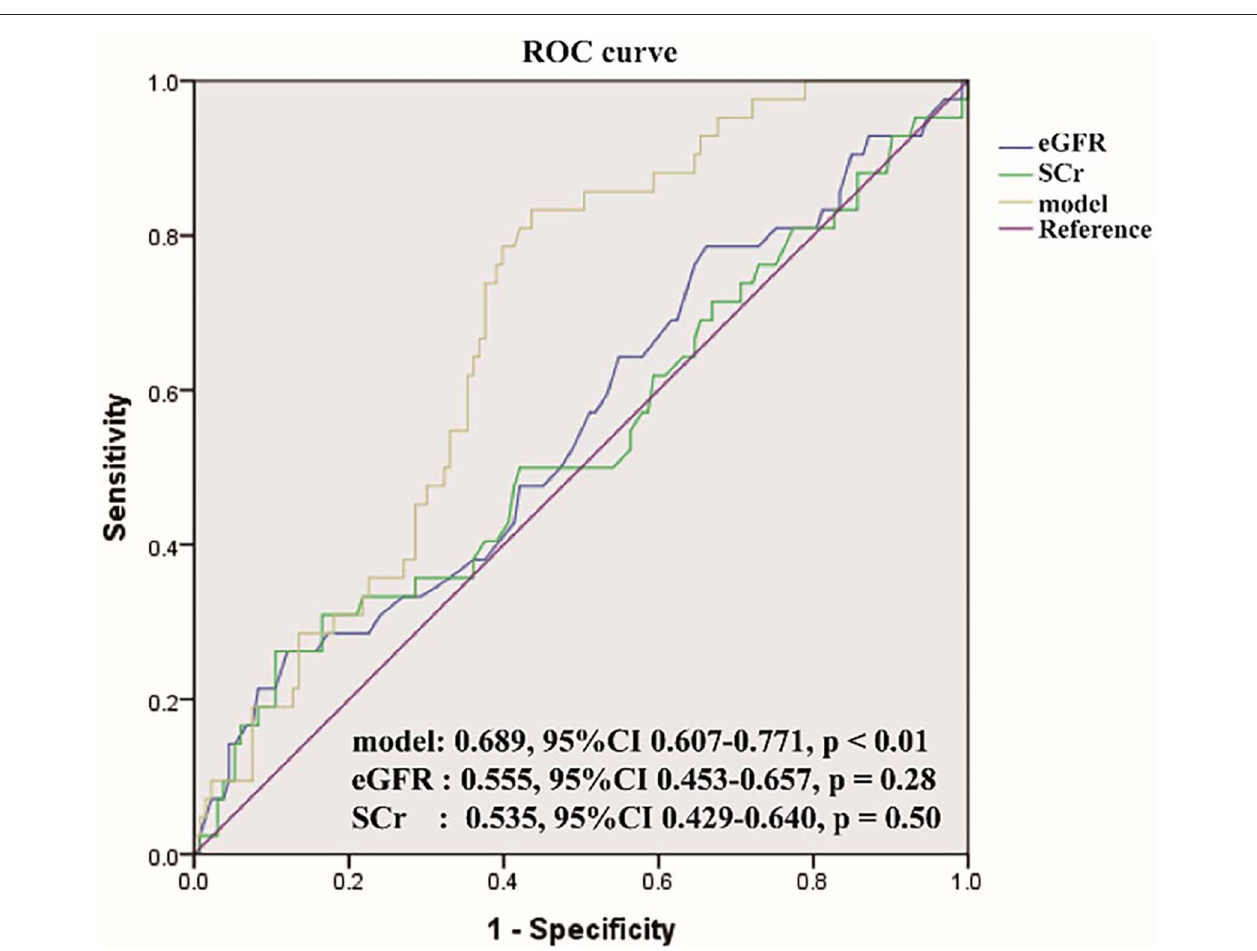
FIGURE 2 | The receiver operating characteristic (ROC) curve of the model compared with serum creatinine (SCr) and estimated glomerular filtration rate (eGFR). The area under the ROC (AUROC) of the three models was 0.689, 0.555, 0.535, respectively, indicating that model has better predictive power.